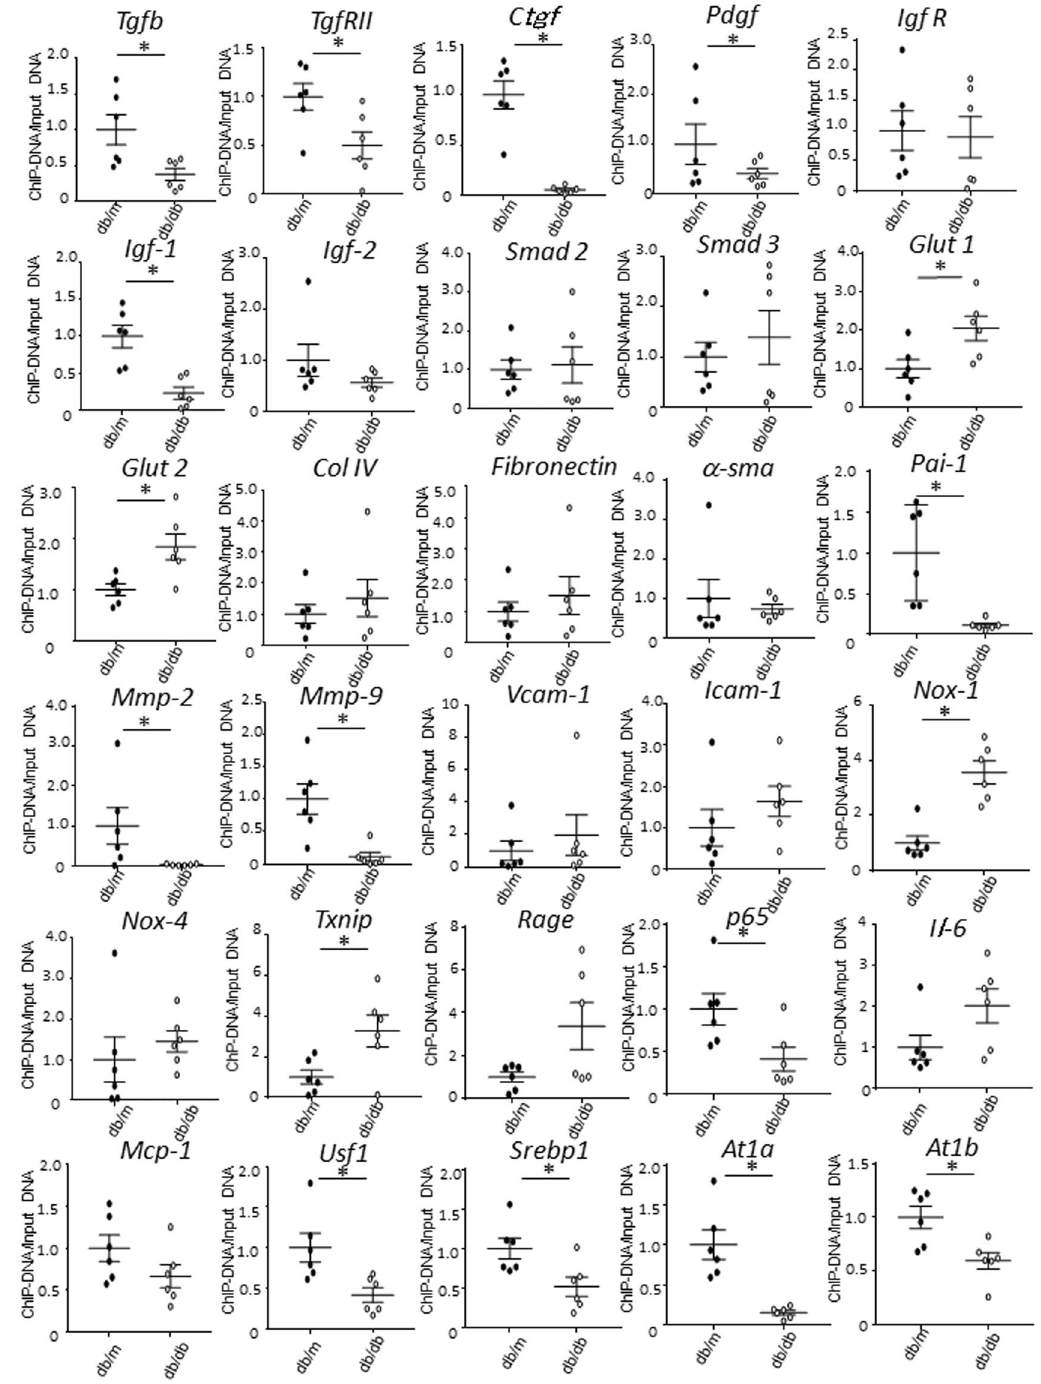
Figure 3. Change of DNA methylation status of fibrosis related genes in mesangial cells of db/m and db/db mice. Data represent the mean ± SEM. n = 6. Filled circles: db/m mice; open circles: db/db